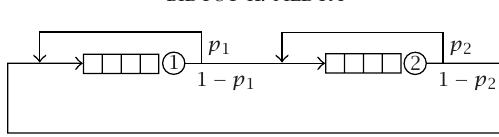
Figure 2.1 . Two-node closed network